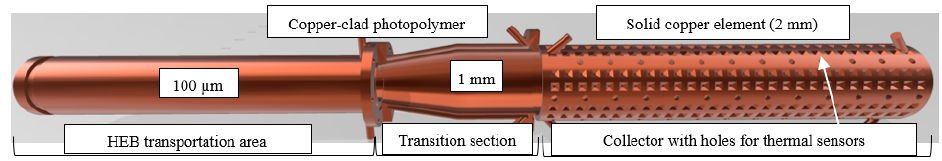
Figure 5. Scheme of the 3D printed part of the research gyrotron.